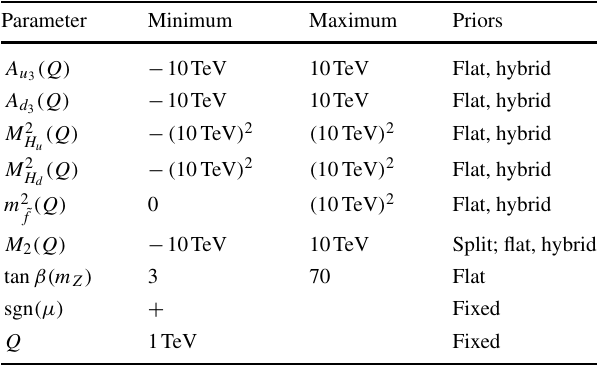
Table 1 MSSM7 parameters, ranges and priors adopted in the scans of this paper. For a parameter x of mass dimension n , the “hybrid” prior is flat where | x | < ( 100GeV ) n , and logarithmic elsewhere. The “split hybrid” prior for M 2 refers to the fact that we carried out every scan twice: once with a hybrid prior over 0 ≤ M 2 ≤ 10TeV, and again with a hybrid prior over − 10TeV ≤ M 2 ≤ 0. In addition to the priors listed here, we also carry out additional scans of fine-tuned regions associated with specific relic density mechanisms, where we restrict models to mass spectra that satisfy various conditions. See text for